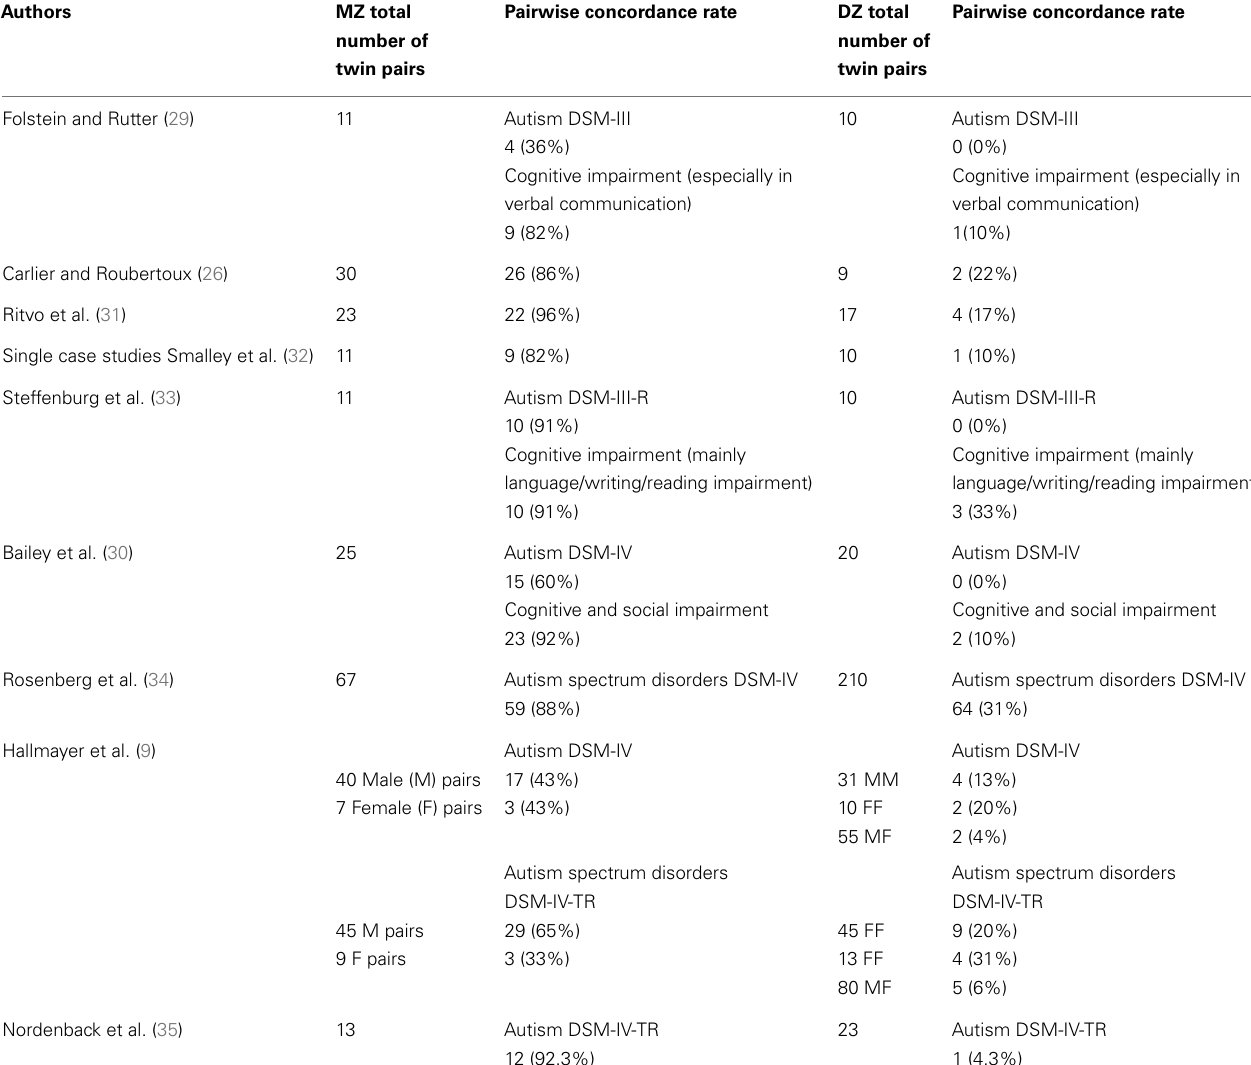
Table 1 | Pairwise concordance rates for autism in monozygotic twins (MZ) and dizygotic twins (DZ) .